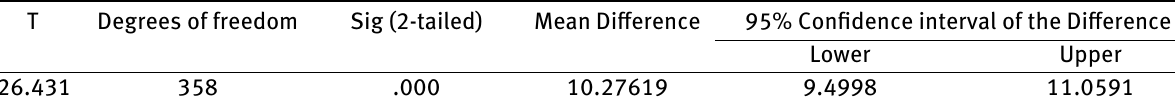
Table 1: One sample test